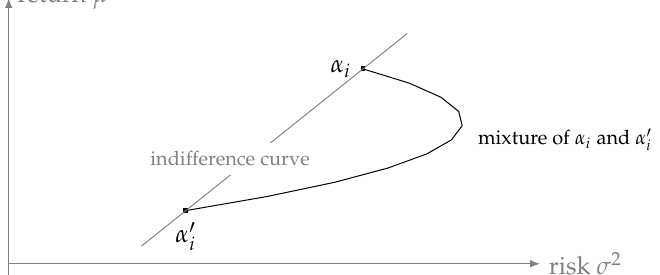
Figure 1. Mixing two lotteries α i and α (cid:48)